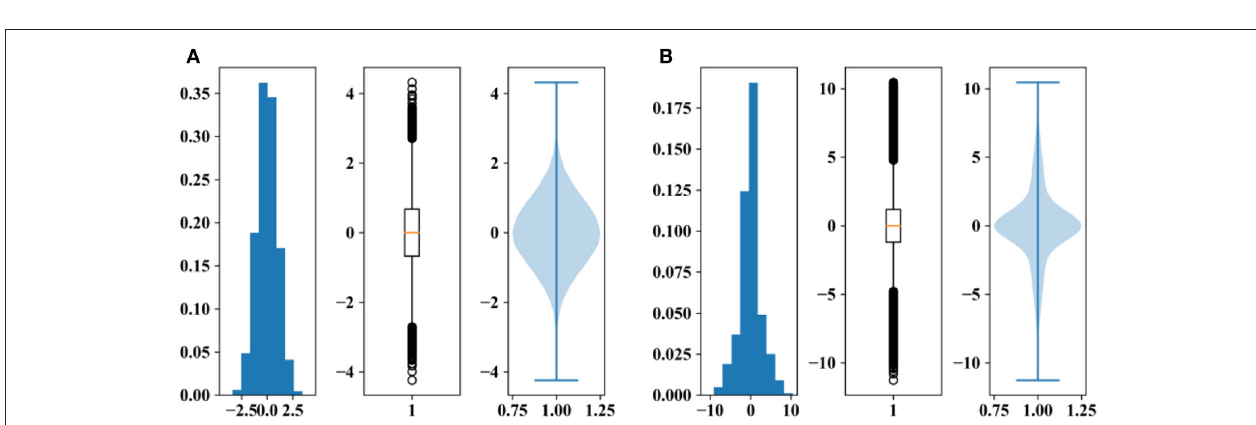
0 and (B) autocorrelation =